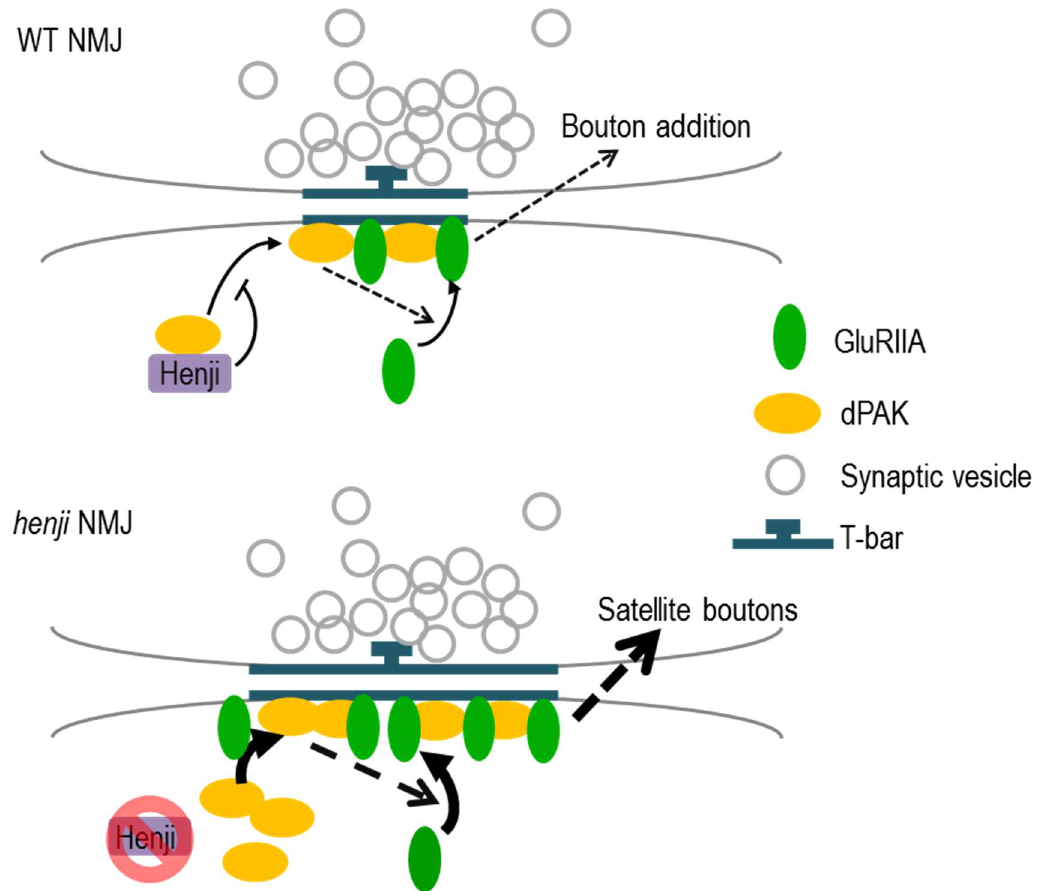
Fig 9. Schematic diagram shows model for Henji function at the NMJ. At WT NMJs, Henji localizesat the SSR and binds with dPAK, preventingdPAK from localizingto the PSDs. With dPAK synaptic levels under control, the rate of GluRIIA clusteringinto PSDs is limited as dPAK is unavailable. At the henji mutant NMJ, unbounddPAK is activated and accumulatesat PSDs to promote GluRIIA clustering and accumulation. Excess GluRIIA enhances presynaptic bouton addition, causing satellite boutons to form. Dashed arrows indicate unknownmechanisms. Curved arrows indicate localizationof moleculesinto PSDs.